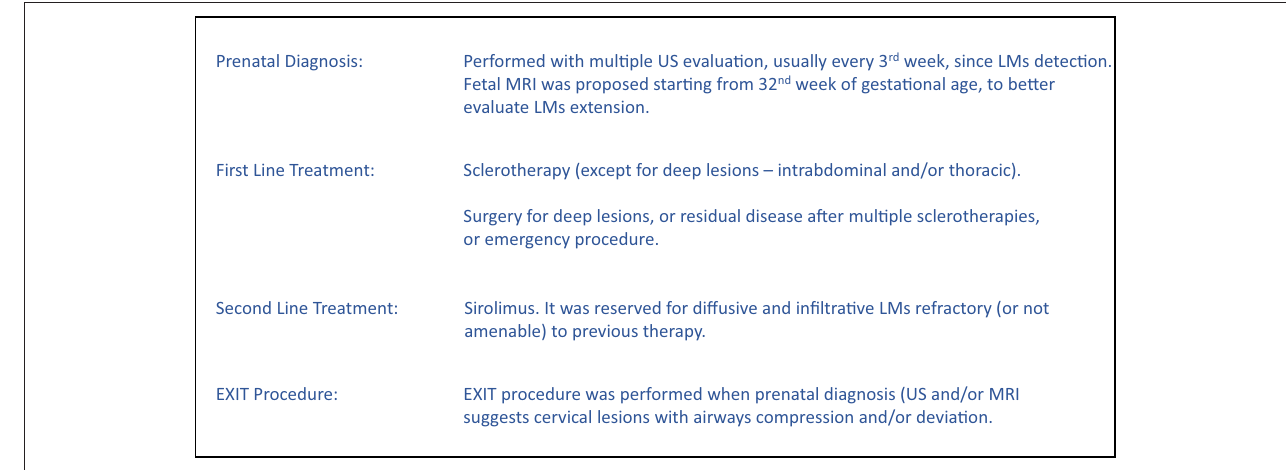
FIGURE 1 | Treatment